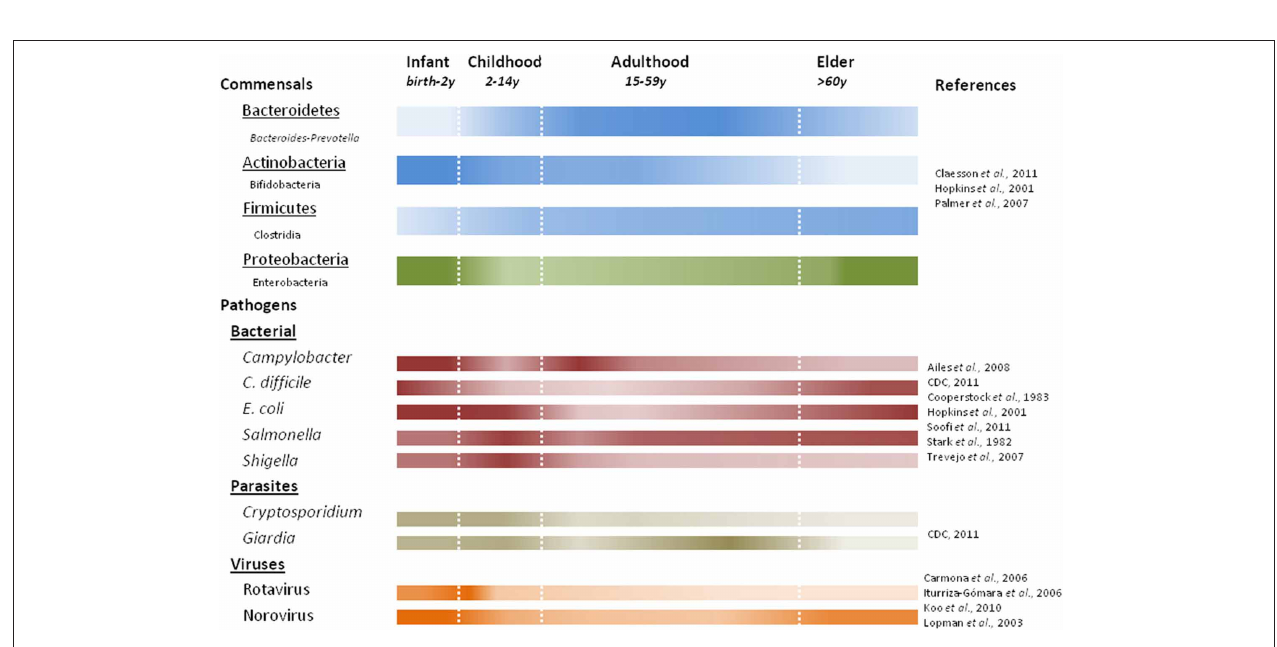
FIGURE 3 | Predominant commensal and pathogenic microbes associated with human life stages. Color intensity of each bar correlates with presence or absence of commensal bacteria at the phylum (underlined)